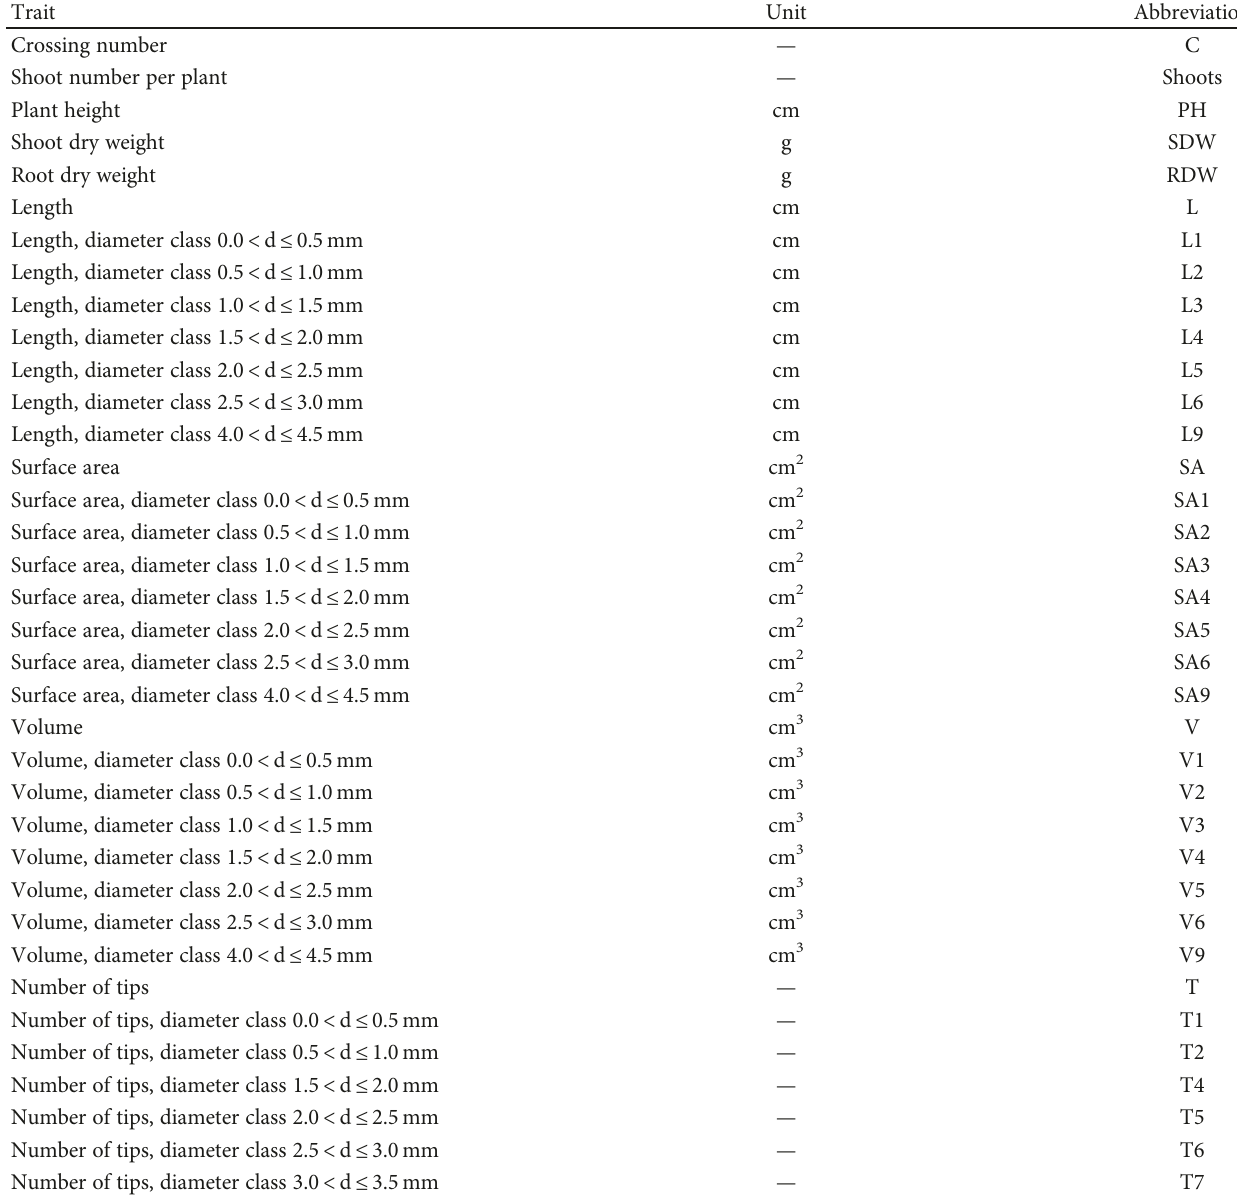
Table 1: Details of all of the traits for which a QTL was identi fi ed in the present